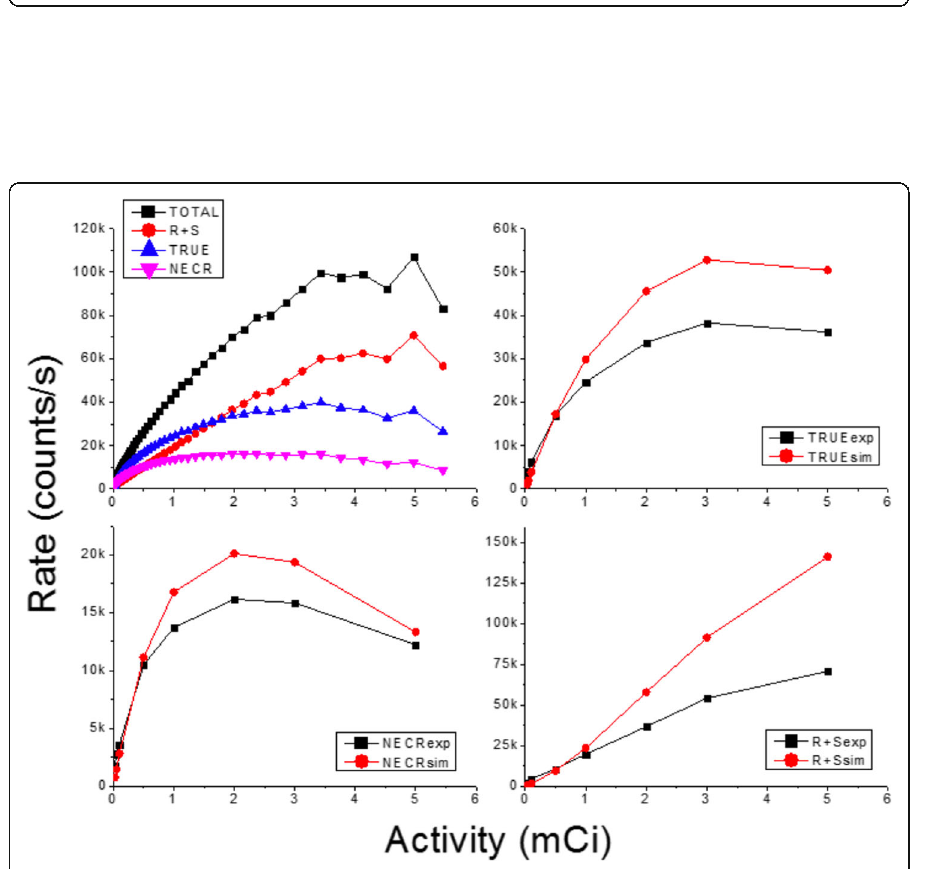
Fig. 11 Top-left, measured values for an activity range from 0 to above 5 mCi. Top-right, comparison experimental and simulation data for the true counts. Bottom-left, same as before but for NECR. Bottom- right, same as before but for the sum of random and